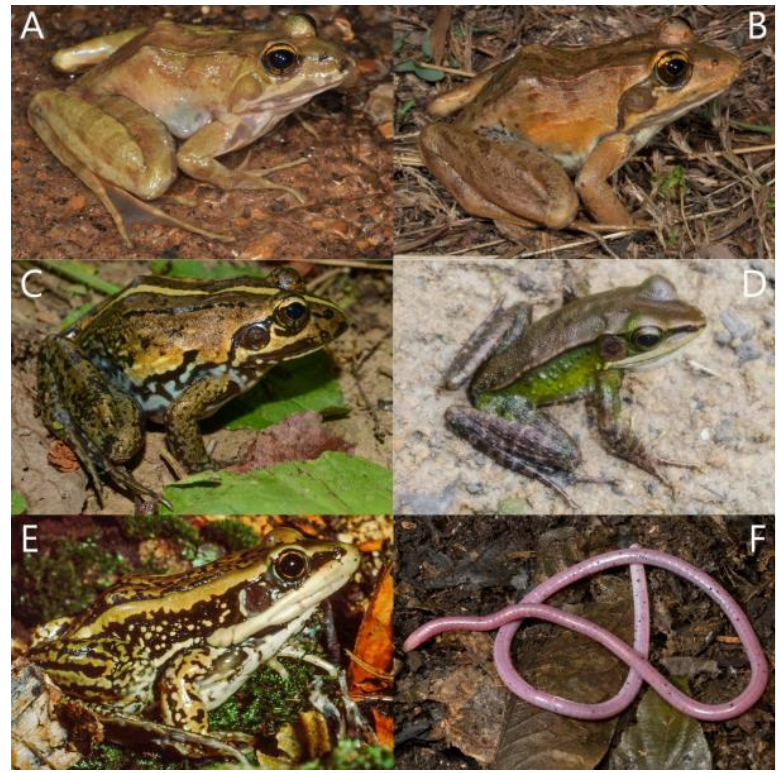
Figure 16. Rwandan species of Pyxicephalidae ( A ) Amietia desaegeri , Gishwati-Mukura NP (photo: J.M.D.), ( B ) Amietia nutti , Huye (photo: J.M.D.), ( C ) Amietia ruwenzorica , Volcanoes NP (photo: J.M.D.); Ranidae ( D ) Amnirana albolabris , South Kivu Province, DR Congo (photo: Bonny Dumbo), ( E ) Amnirana galamensis , Eastern Province (photo: Eberhard Fischer); and Herpelidae ( F ) Boulengerula fischeri , Cyamudongo Forest (photo: J.M.D.).